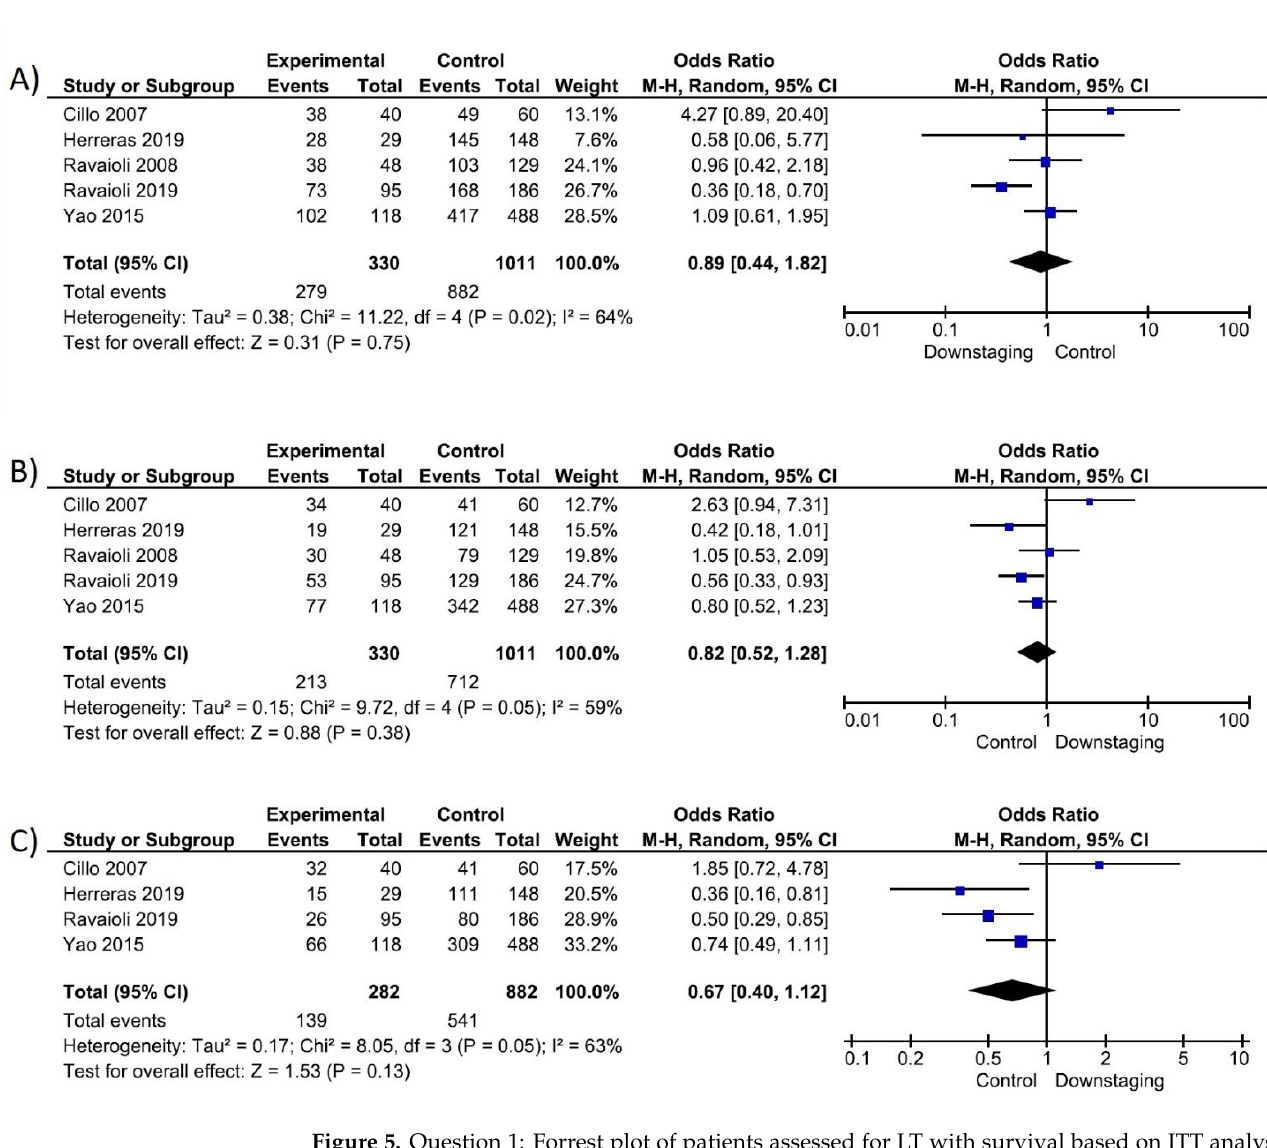
Figure 5. Question 1: Forrest plot of patients assessed for LT with survival based on ITT analysis: ( A ) 1y-overall survival; ( B ) 3y-overall survival; ( C ) 5y-overall survival. (d) Sensitivity Analysis Table 5. Question 2, summary of